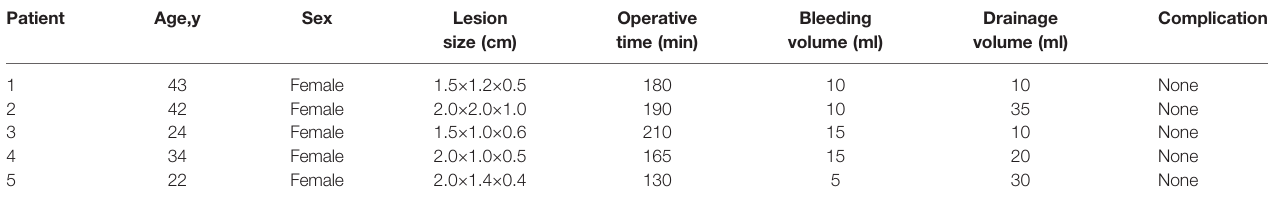
TABLE 1 | Patient demographics and outcomes for undergoing transoral approach for TGDC.